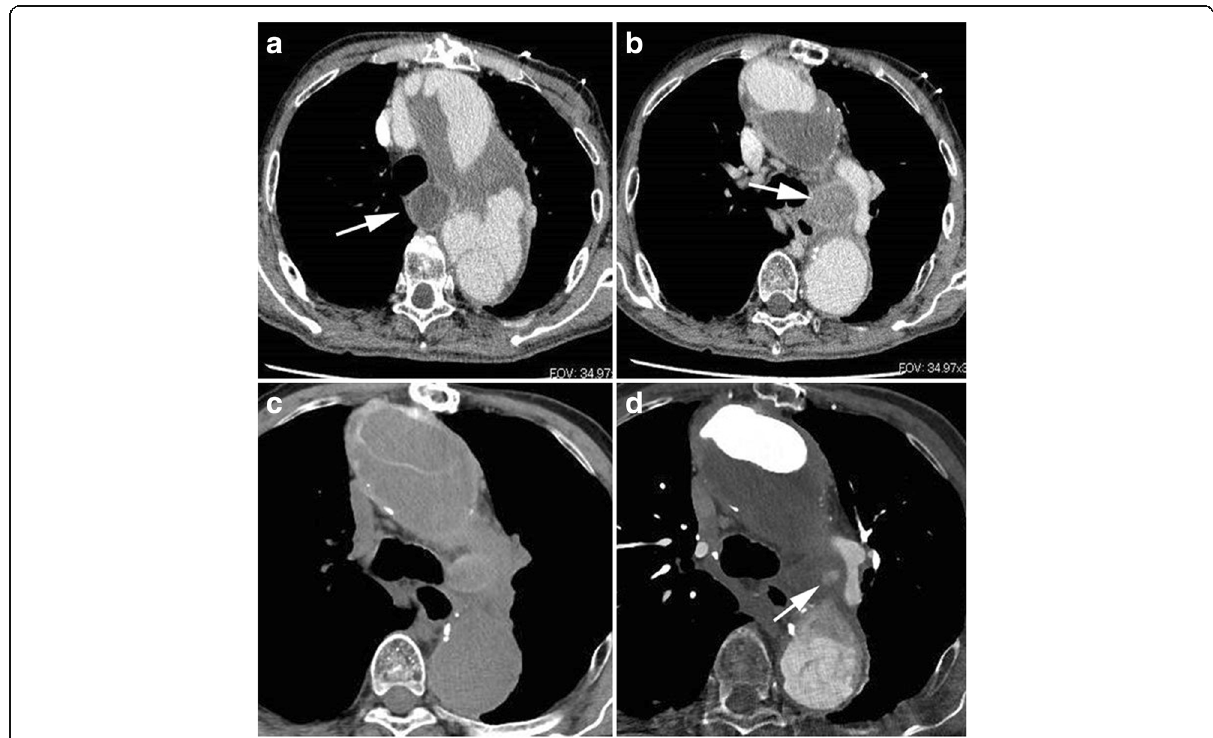
Fig. 1 A 76-year-old male with massive hemoptysis. a and b . CT showed two aortic pseudoaneurysms (arrows), which were in contact with the aortic anastomoses. They were attached to the trachea and left bronchus, respectively, which was suggestive of AB fistula formation. c and d